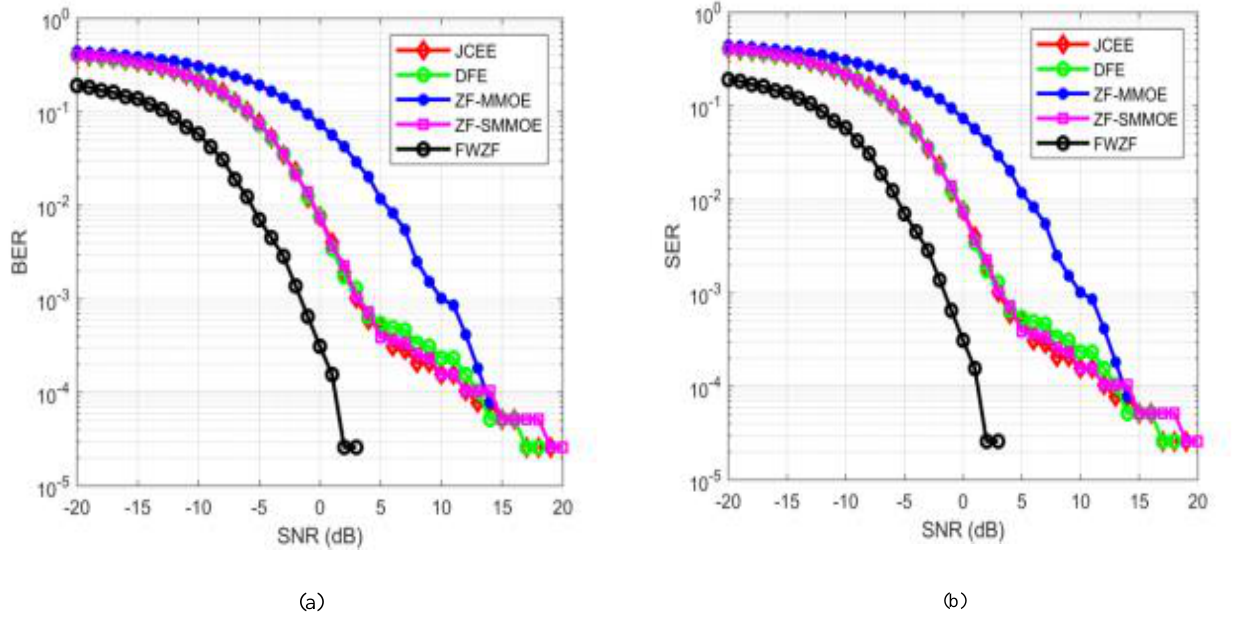
Fig.6. Comparative analysis using antenna=6 in Rayleigh channel, (a) BER, (b) SER